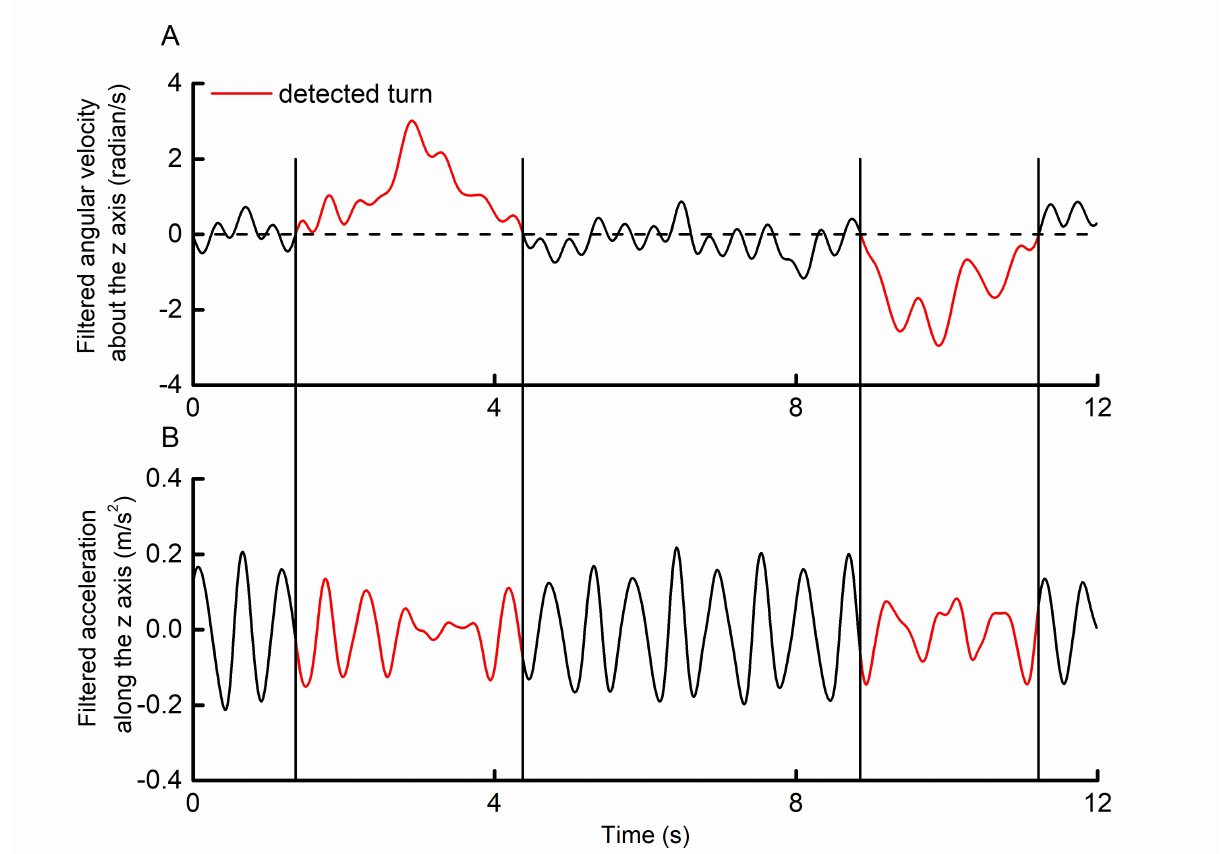
Figure 4. Example of smartphone-recorded (A) angular velocity and (B) acceleration relative to the earth coordinate system vertical axis during in-home walking with 2 detected periods of turning. Turns were identified from angular velocity time series and defined as any period between 2 consecutive zero crossings in which the product of the area under the curve and the time between zero crossings was >2.00 radian-seconds. Acceleration patterns were noticeably different during these periods. Average stride times from home assessment trials were thus computed from stride times derived only from nonturning